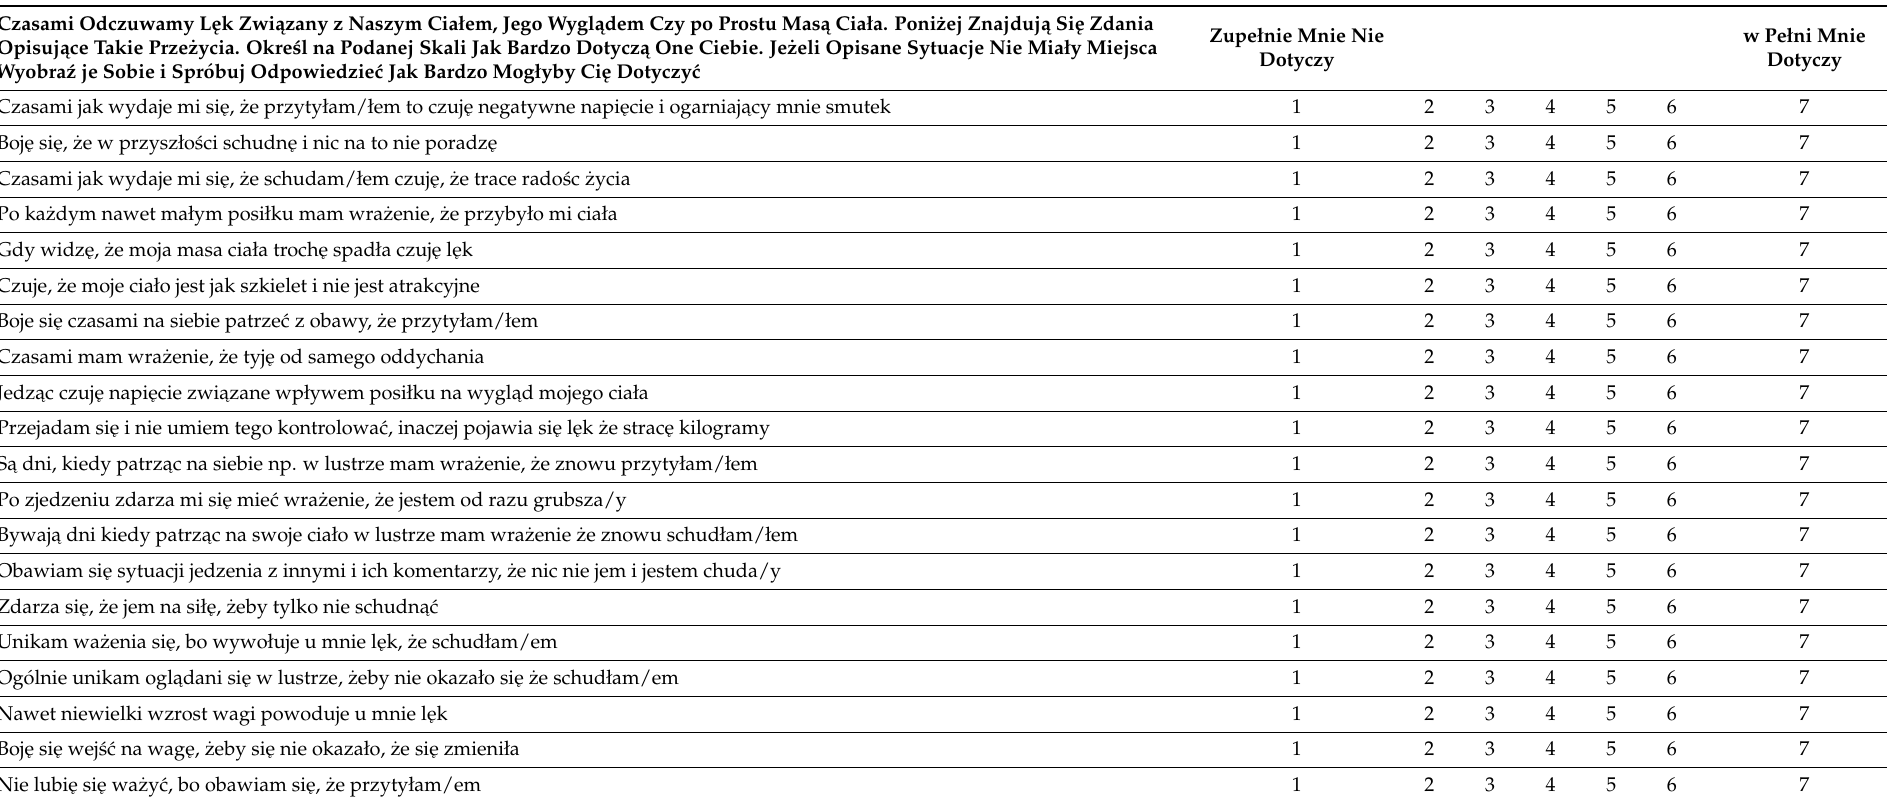
Table A1. PL-BMAS-20 by Wojciech